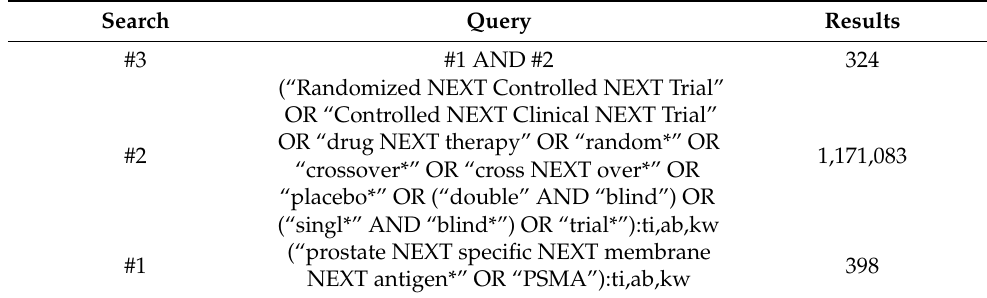
Table A4. Search strategy in Wiley/Cochrane